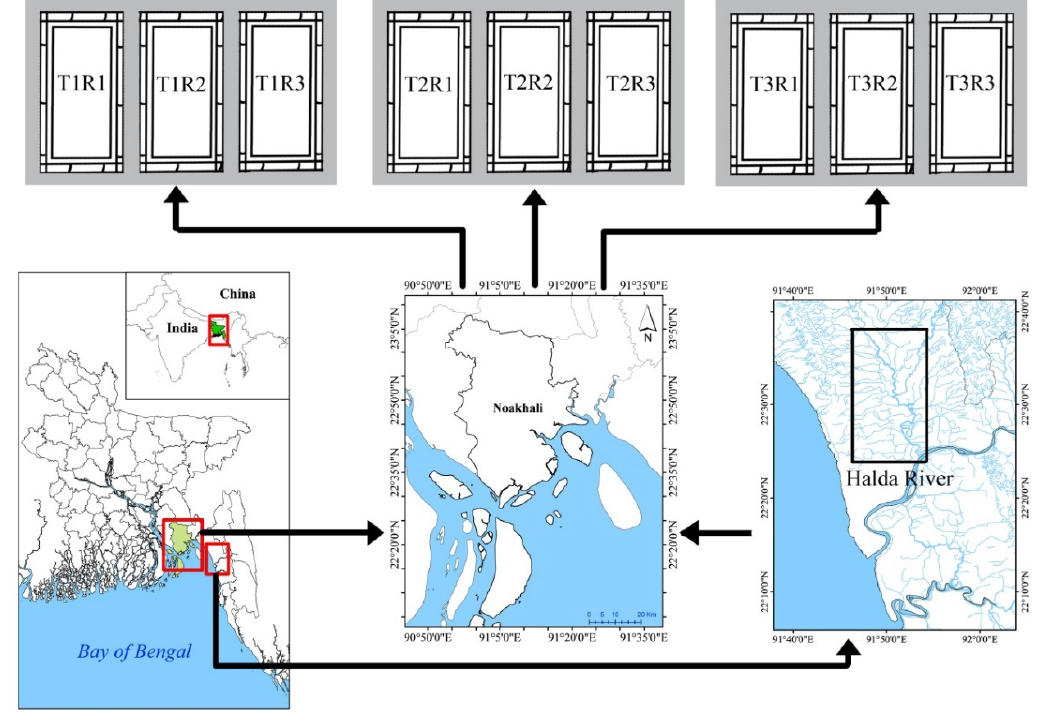
Figure 1. Location of study site and sampling design.